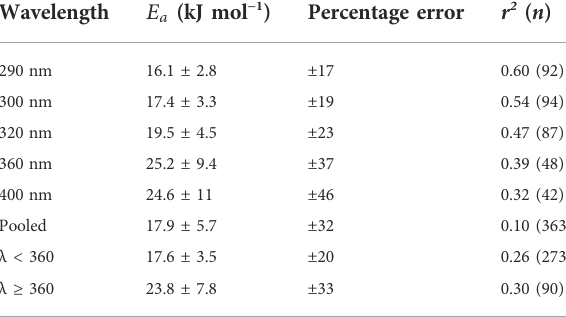
TABLE 4 E a (kJ mol − 1 ) determined from the slope of the linear regression of ln [ Φ ( λ )] versus 1/T (K) and an R value of 8.315 × 10 – 3 kJ K − 1 mol − 1 at each wavelength as listed. Data were originally reported by Kieber et al. (2014). A pooled E a was determined by a regression of all ln [ Φ ( λ )] versus 1/T data, regardless of wavelength. E a at λ < 360 and λ ≥ 360 were also determined to assess the variability in E a used in the global H 2 O 2 model. Errors associated with E a denote the margin of error with 95% con fi dence level.